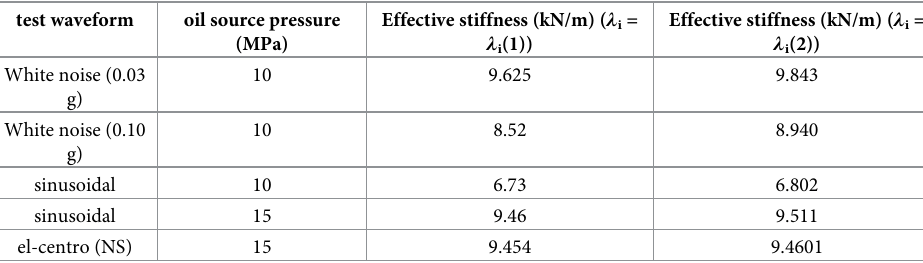
Table 4. System effective stiffness ( α =